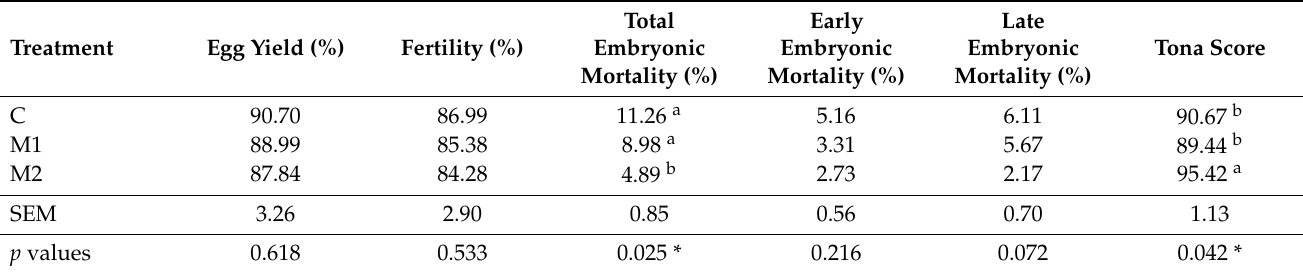
Table 6. The mean values of egg yield, reproductive characteristics, chick quality and results of variance